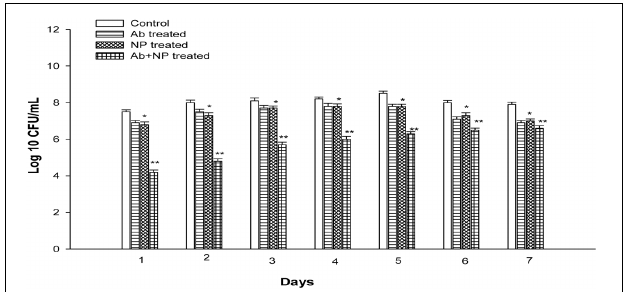
FIGURE 8 | The effect of H-AgNPs alone [fractional inhibitory concentration (FIC)], antibiotic alone (FIC), and H-AgNPs +antibiotic treatment (FIC value) on biofilm. The experiment was performed in duplicate and repeated at least three times on different days. Bars represent standard deviation, ∗ denotes ( P < 0.05) and ∗∗ denotes ( P < 0.01).